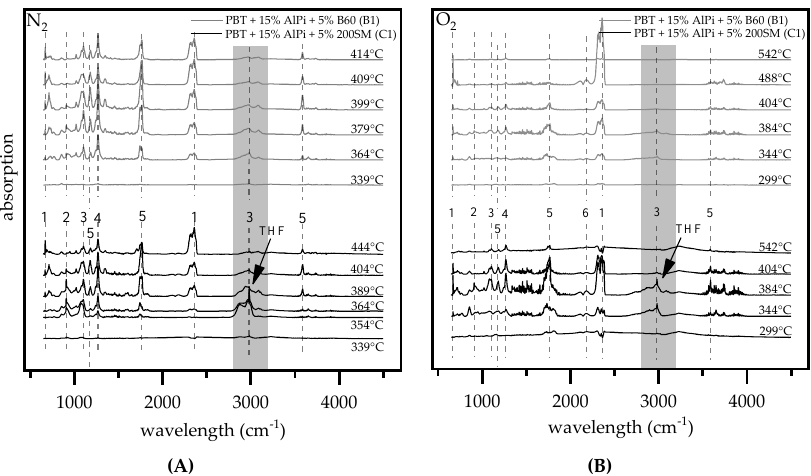
Figure 6. FTIR spectra of evoluted gases conducted under nitrogen ( A ) and oxygen ( B ) atmosphere at a TGA heating rate of 5 K/min.; ( 1 ) CO 2 , ( 2 ) 1,3 butadiene, ( 3 ) THF, ( 4 ) therephthalic ester, and ( 5 ) benzoic